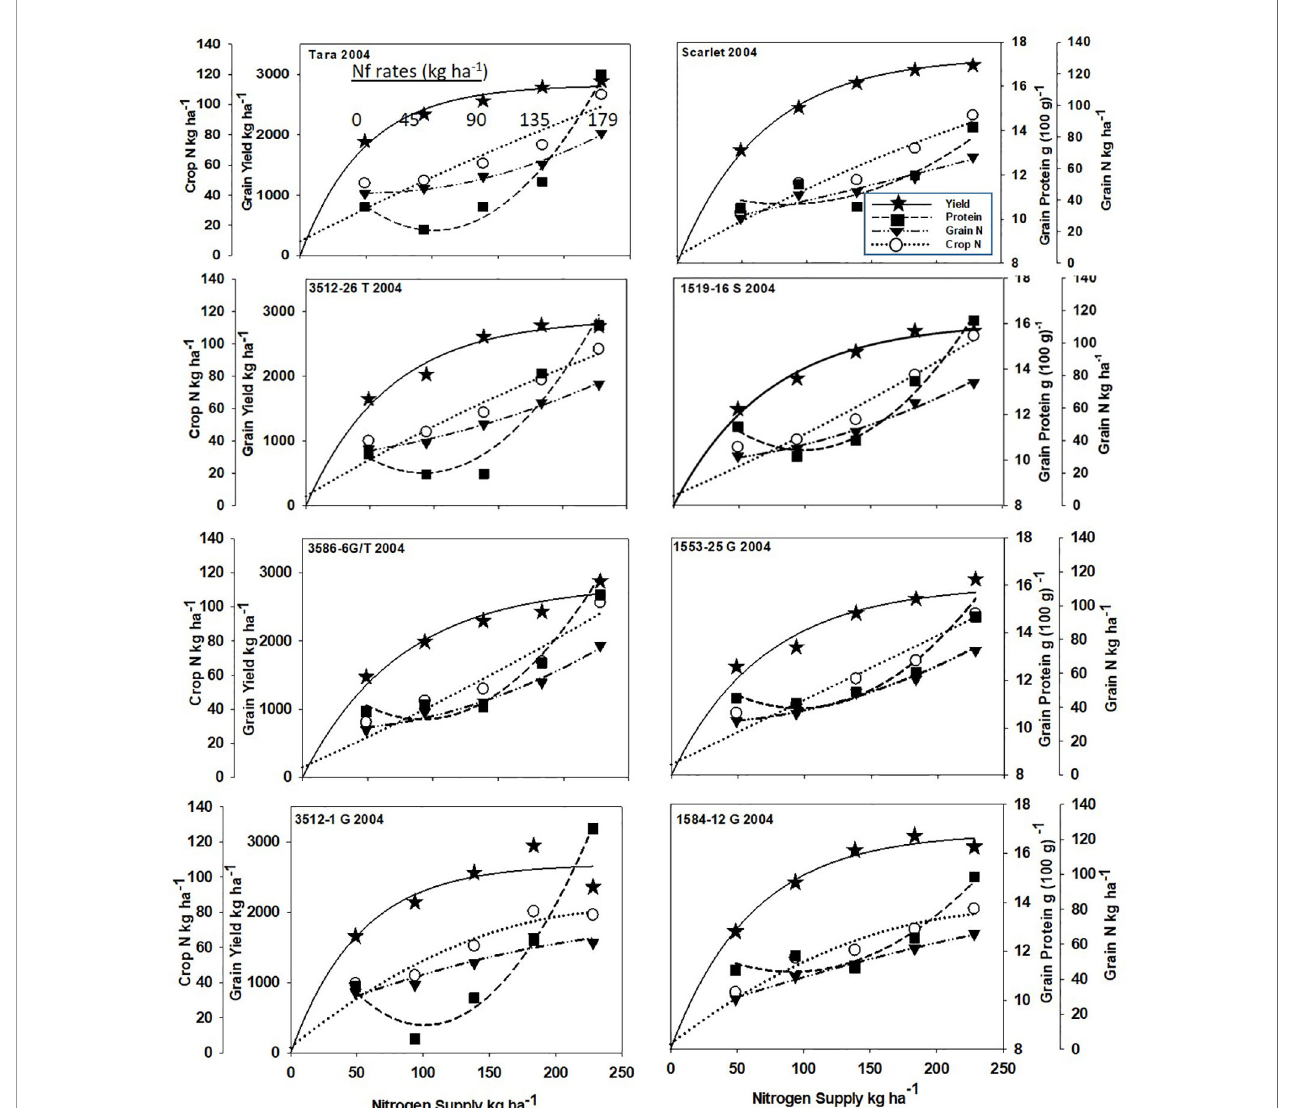
FIGURE 1 | Grain yield, grain N concentration, grain N yield, and crop N responses to increasing N supply at Dusty WA in 2004 of HRS cultivar Tara and its derivatives 3512-26T, 3586-6G/T, 3512-1G; HRS cultivar Scarlet and its derivatives 1519-16S, 519-16S, 1553-26G and 1584-12G. Symbols represent means of 4 N rate replicates. Regression coef fi cients of responses modeled on entire datasets of each dependent variable are presented in Tables 1 and S1